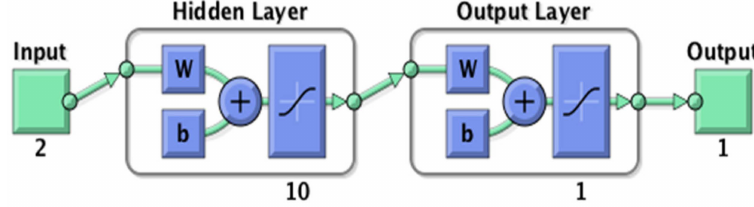
Figure 6. The ANN classifier for LOL estimation for model